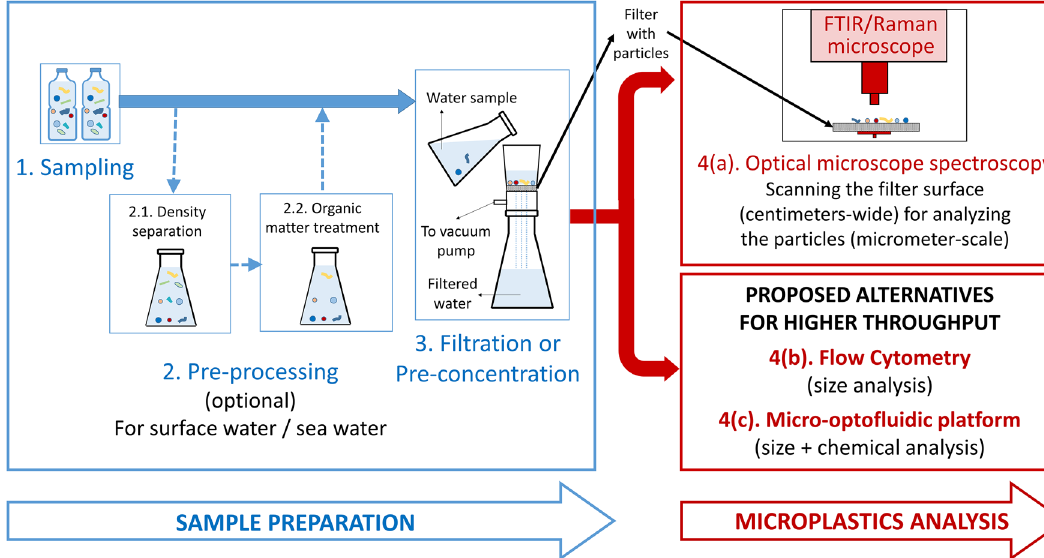
Figure 1. An illustration for water analysis process steps. First, common steps are required which include sampling (of tap water, bottled-water…etc.) Then, for some samples types (which can be more contaminated such as surface water) a step of pre-processing is required, where density separation is used in addition to treatment of organic matter to digest organic matter leaving only plastics in the sample. This is followed